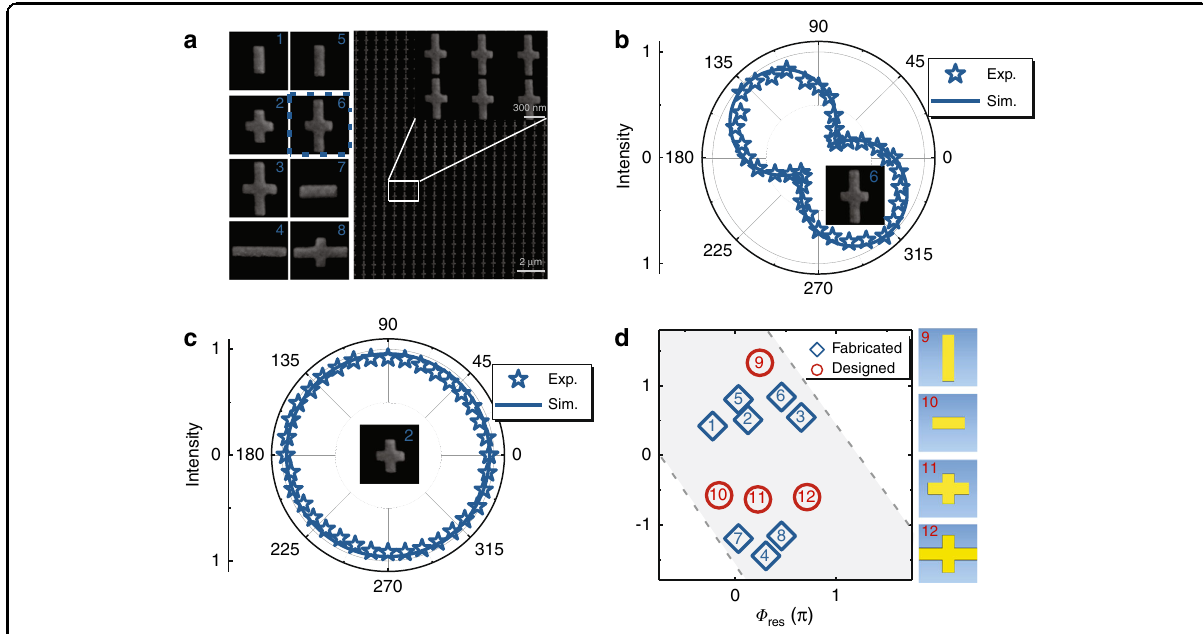
Fig. 4 Experimental/numerical characterization of designed meta-atoms. a Scanning electron microscopy (SEM) images of 8 experimentally characterized meta-atoms and a periodic metasurface containing an array of the 6 th meta-atom with geometrical parameters L u ¼ 303nm, L v ¼ 564nm, and P u ¼ P v ¼ 600nm. Polarized- fi ltered intensity patterns of light re fl ected by periodic metasurfaces containing b the 6 th meta-atom and c the 2 nd meta-atom under the illumination of normally incident LP light at 1550 nm, obtained by experiments (stars) and simulations (line). d Locations of fabricated and designed meta-atoms on the ΔΦ (cid:6) Φ res phase diagram obtained by numerical simulations and experimental results at 1550